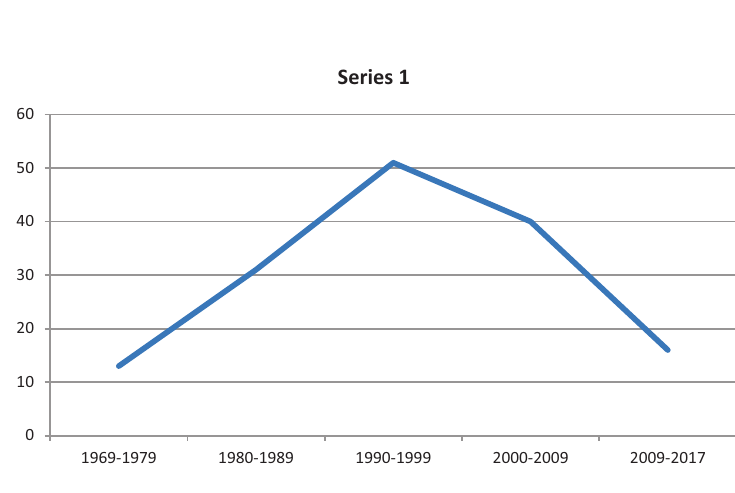
Table 1. Journal-wise distribution of